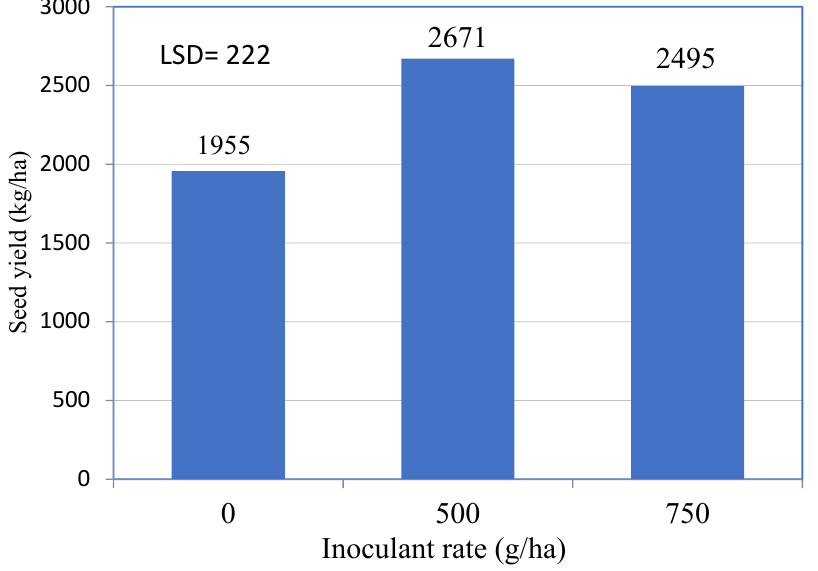
Figure 2. Effect of inoculant rates on seed yield of the faba bean. The higher rate of inoculation did not increase yield, with the application of 0 and 60 kg ha − 1 blended fertiliser, where the number of active nodules was low for unknown rea- sons, and thus the level of N 2 fixation remained low. The straw yield of the crop ranged from 3.4 to 5.4 t ha − 1 , and significantly ( p < 0.01) increased with an increase in blended fertiliser; however, the other effects remained insignificant ( p > 0.05).